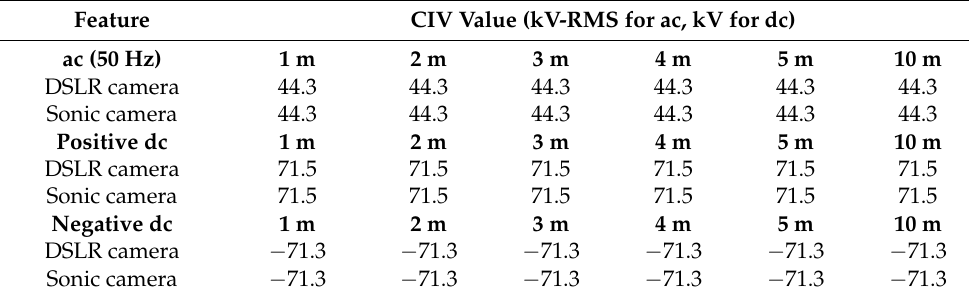
Table 3. CIV values that were obtained with the sphere-plane gap.